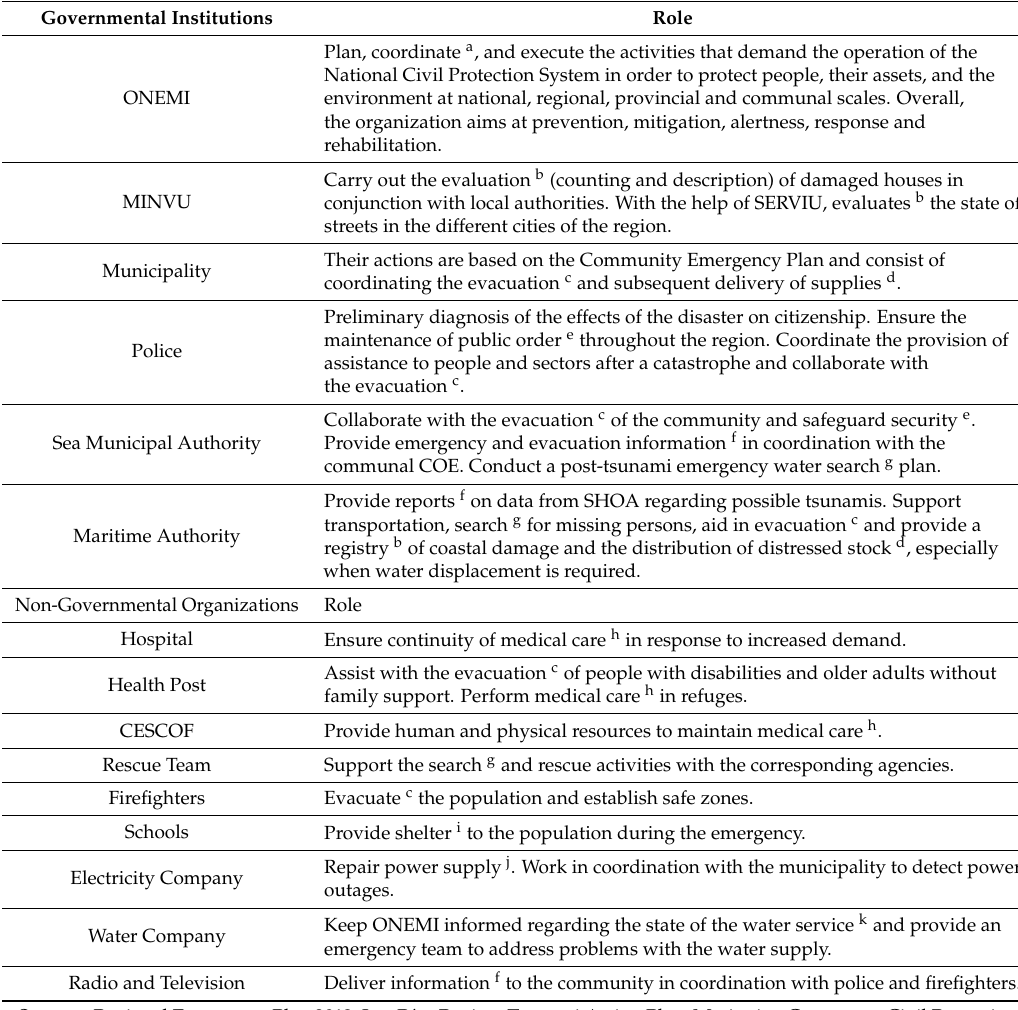
Table 1. Roles of emergency